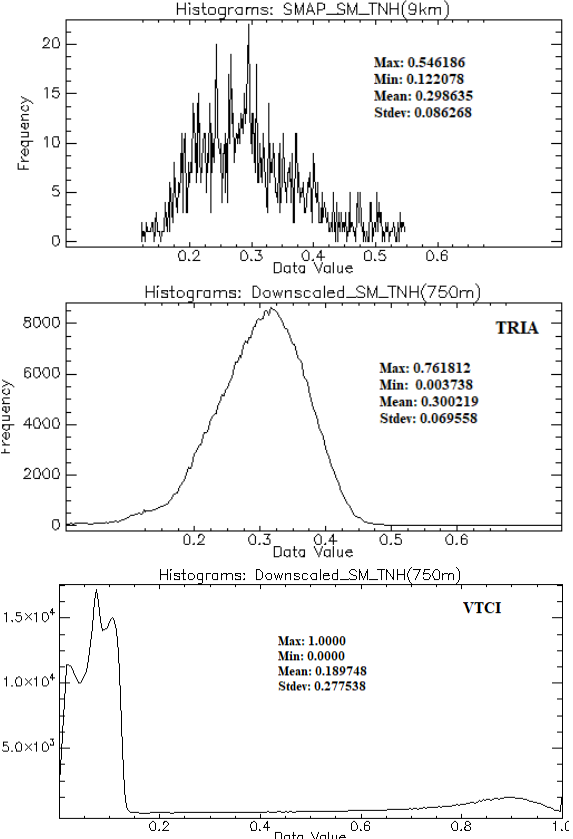
Figure 7. The histograms of original SMAP soil moisture and downscaled soil moisture by TRIA and VTCI method for the TNH